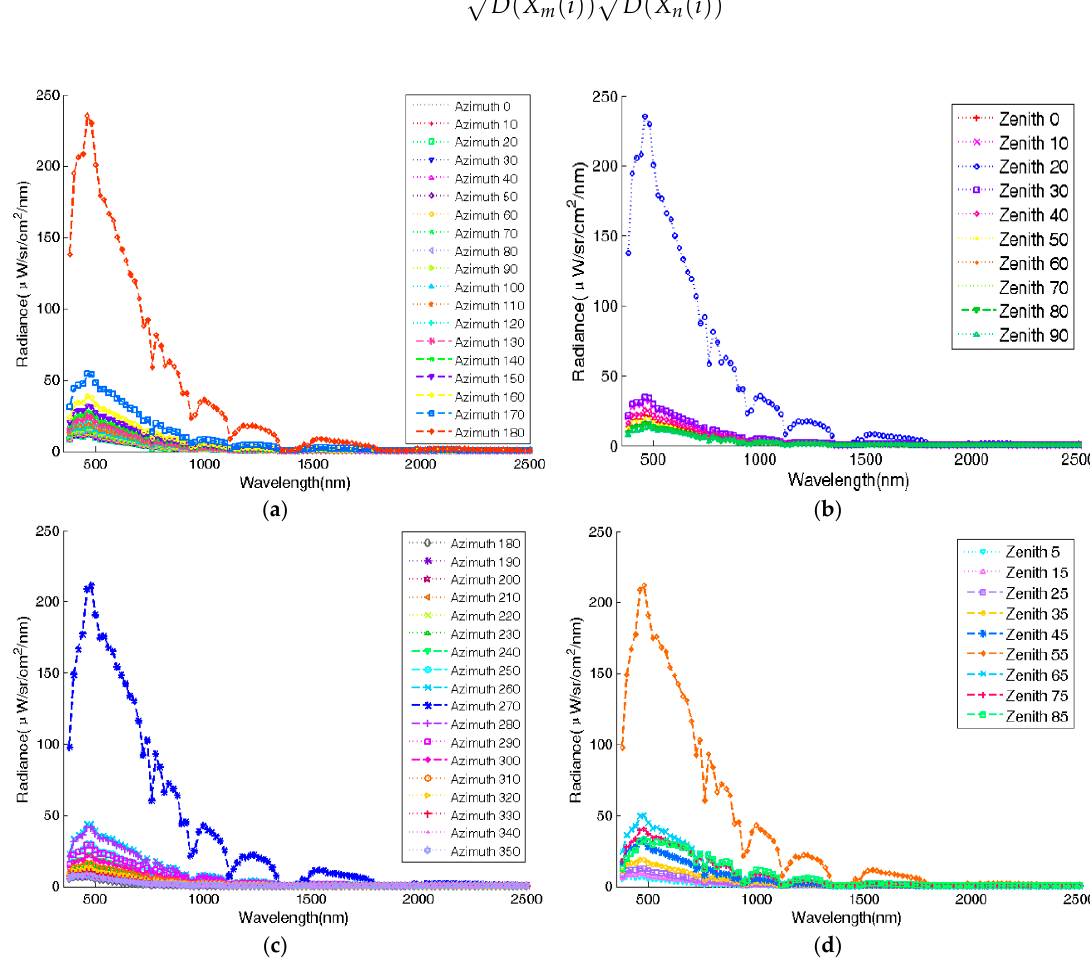
Figure 2. The radiance of the skylight: ( a ) The spectral radiance from zenith 20 ° and different azimuths at 12:00; ( b ) The spectral radiance from azimuth 170 ° and different zeniths at 12:00; ( c ) The spectral radiance from zenith 20 ° and different azimuths at 16:00; ( d ) The spectral radiance from azimuth 170 ° and different zeniths at 16:00. Table 2. The correlation between azimuthal-average spectral radiances and different zenith angles.